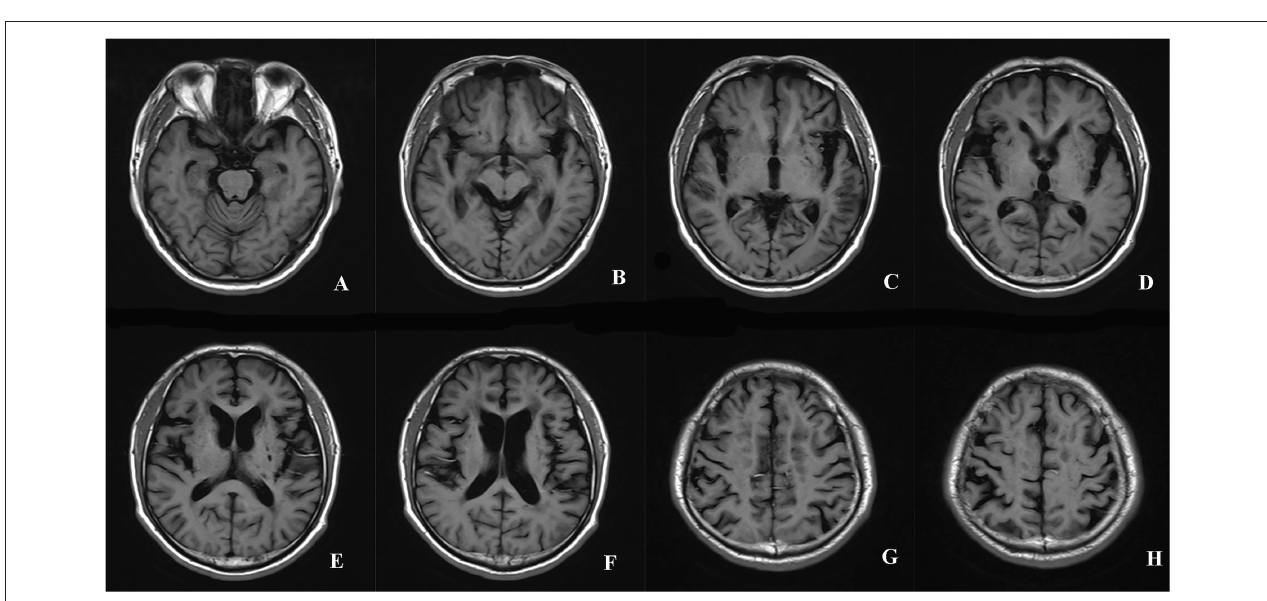
FIGURE 2 | The rating of the GCA scale in a patient with CADASIL. The scores of the sulcal dilation in the regions of bilateral frontal (2 + 2), parieti-occipital (2 + 2), and temporal (3 + 3) were summed to calculate the superficial atrophy score (A-H) . The superficial atrophy score of the patient was 14. The dilation of ventricles in bilateral frontal, parieto-occiptial, temporal and the third ventricles was assigned 2 + 2, 2 + 2, 2 + 2, 2 points, respectively (A-F) . The deep atrophy score of the patient was 14. Total GCA score was 28. GCA, Global Cortical Atrophy; CADASIL, Cerebral Autosomal-Dominant Arteriopathy with Subcortical Infarcts and